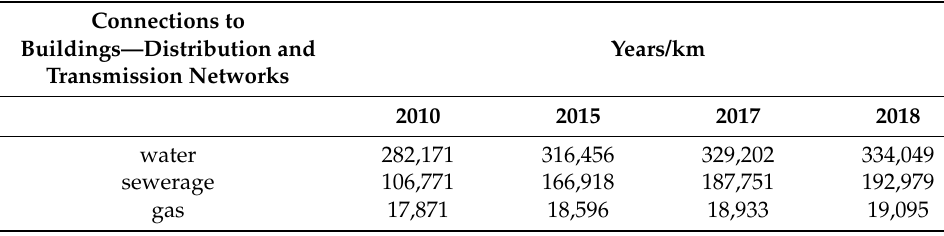
Table 3. Length of industrial networks in rural communes from 2010 to 2018. Connections to Buildings—Distribution and Transmission Networks